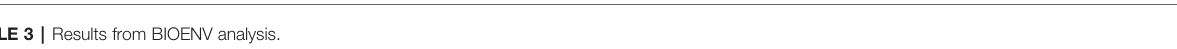
TABLE 3 | Results from BIOENV analysis.